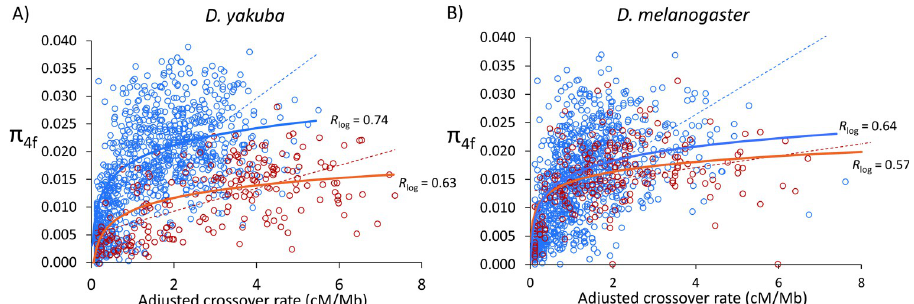
Fig 9. Relationship between crossover rate (cM/Mb) and levels of neutral nucleotide polymorphism ( π 4f ) in D . yakuba and D . melanogaster . π 4f indicates pairwise nucleotide variation (/bp) at four-fold synonymous sites. Autosomal and X -linked regions are indicated as blue and red circles, respectively. Crossover rates are adjusted to allow a direct comparison between X -linked and autosomal regions. Dashed lines indicate linear regressions between π 4f and adjusted crossover rates; solid lines indicate regressions between π 4f and the log 10 of crossover rates. Data shown for non-overlapping 100-kb windows.